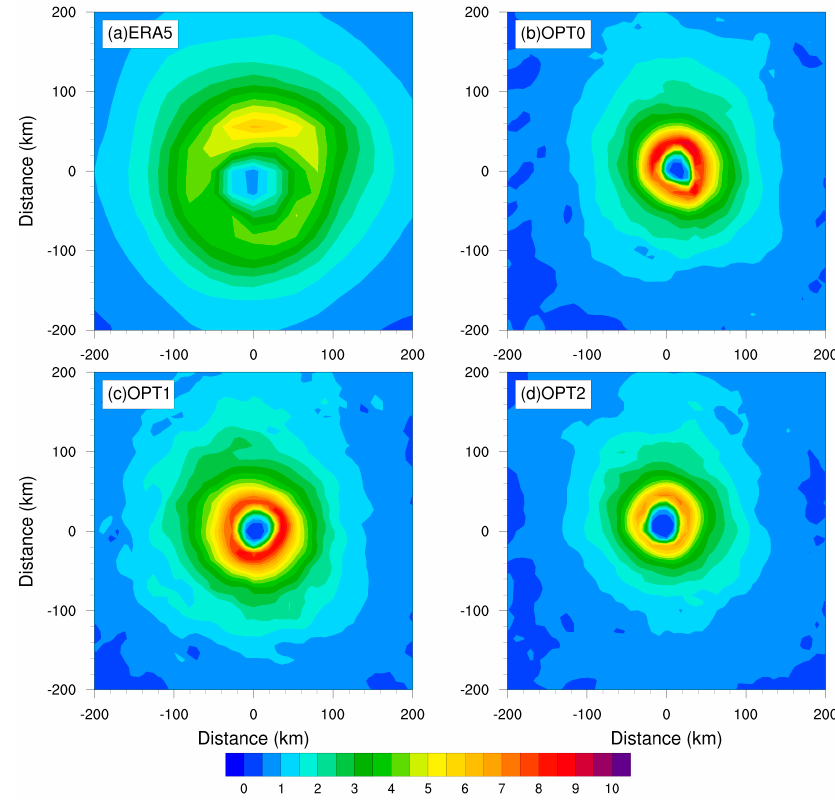
Figure 7. As in Figure 5 but for surface momentum flux (unit: kg m − 1 s − 2 ). Consistent with the magnitude relationship of TC intensity, OPT1 produced the larg- est latent flux and sensibility, followed by OPT0 and OPT2. This better simulation of TC intensity by OPT0 can be attributed to the steady increase in latent flux for high wind speed. The larger latent heat flux transfer results in stronger moist convection, thereby leading to stronger TC intensity for simulation through thermo-dynamical interactions [37]. Similarly, OPT1 produced larger momentum flux than OPT0 and OPT2, since mo- mentum flux is influenced by wind speed. Overall, the difference in momentum is rela- tively small due to the same peak 𝐶 (cid:3031) for the three schemes. In general, although sharing the same upper limit in 𝐶 (cid:3031) as OPT0 and OPT2, OPT1 has much larger 𝐶 (cid:3038) than the other two options, which leads to larger enthalpy flux, and especially latent heat flux, and thus stronger TC intensity. 3.4. TC Wind Field In this subsection, the height–radius distribution of azimuthally averaged tangential wind, radial wind, and upward vertical wind within 200 km from the TC center 1200 UTC 12 September simulated by the three schemes are analyzed. Similar with the last subsec- tion, 1200 UTC 12 September is chosen to represent the TC mature stage when the simu- lated TC reached its peak intensity. Additionally, ERA5 reanalysis data are used as a ref- erence to compare the simulation results. Although ERA5 generally underestimates the TC intensity, it provides an effective reference for TC size [44]. Consistent with TC inten- sity results in Figure 3, the wind speed of ERA5 is significantly weaker than the simulated